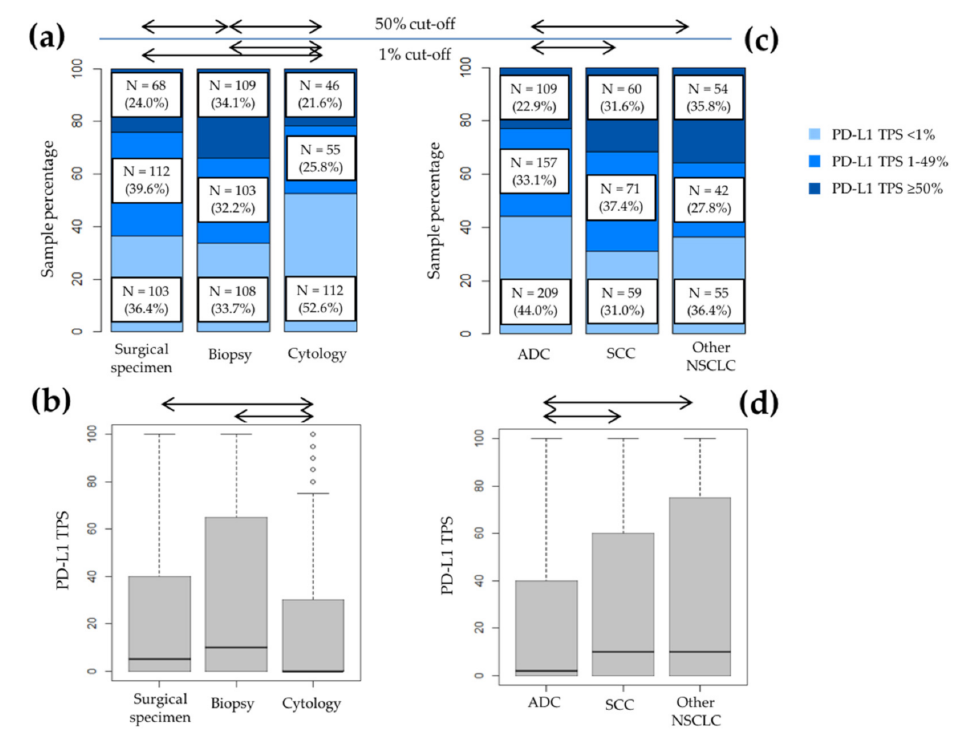
Figure 2. PD-L1 expression was different in each type of sample and tumor histology. ( a ) Bar plot and ( b ) box plot of the comparison of PD-L1 expression with the type of sample. The type of sample was statistically significantly related to PD-L1 expression as a three-category analysis ( p < 0.001), separately analyzing the cut-off points TPS 1% and TPS 50% ( p < 0.001 and p = 0.002, respectively), and as a continuous variable ( p < 0.001). ( c ) Bar plot and ( d ) box plot of the relationship between PD-L1 expression and tumor histology. Differences were observed when evaluating PD-L1 as a categorical variable (both as a three-category variable, p = 0.002; and a two-category analysis in the cut-off points TPS 1% and TPS 50%, p = 0.006 and p = 0.003, respectively), and as a continuous variable ( p = 0.001). Arrows indicate a statistically significant result ( p < 0.05). Abbreviations: ADC, adenocarcinoma; SCC, squamous cell carcinoma; NSCLC, non-small cell lung cancer; PD-L1, programmed cell death ligand 1; TPS, tumor proportion